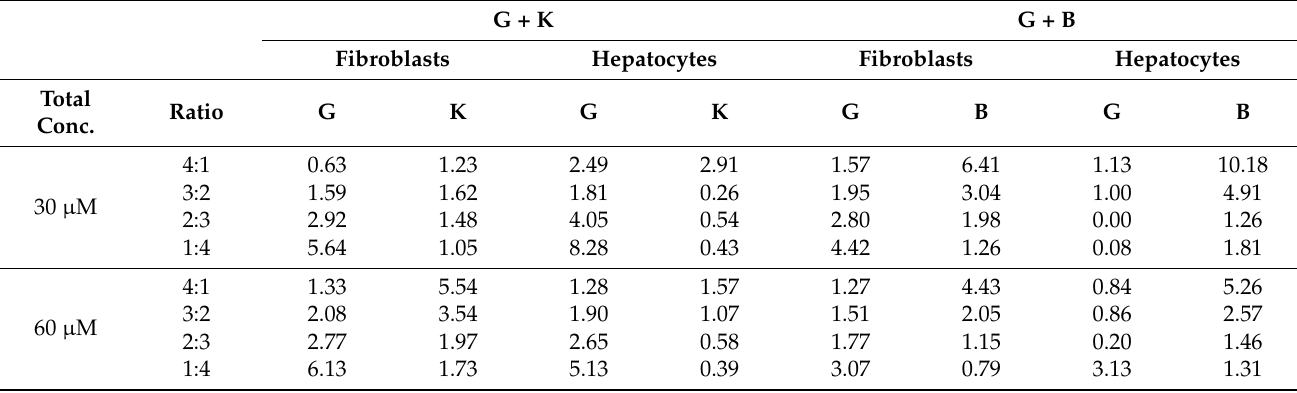
Table 1. Dose reduction index (DRI) for mixtures of genistein and kaempferol, and genistein